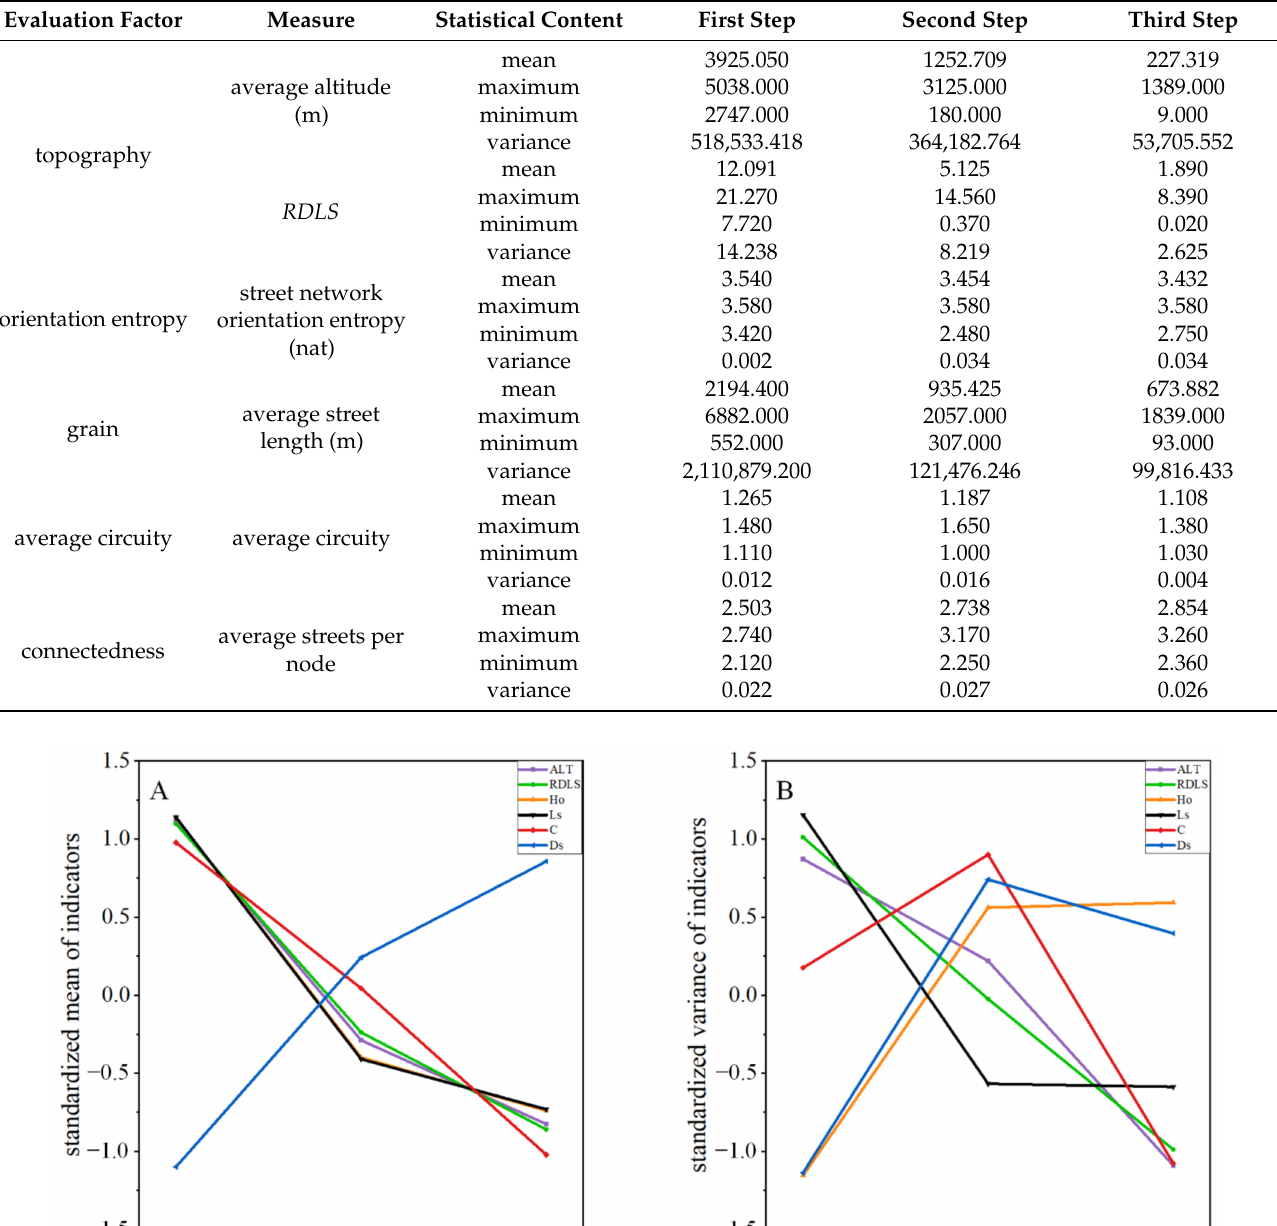
Table 2. Graduation statistics results based on RDLS .